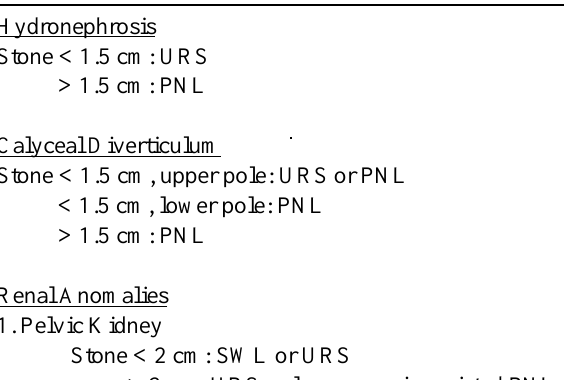
Table 3 - Approaches to renal calculi in special